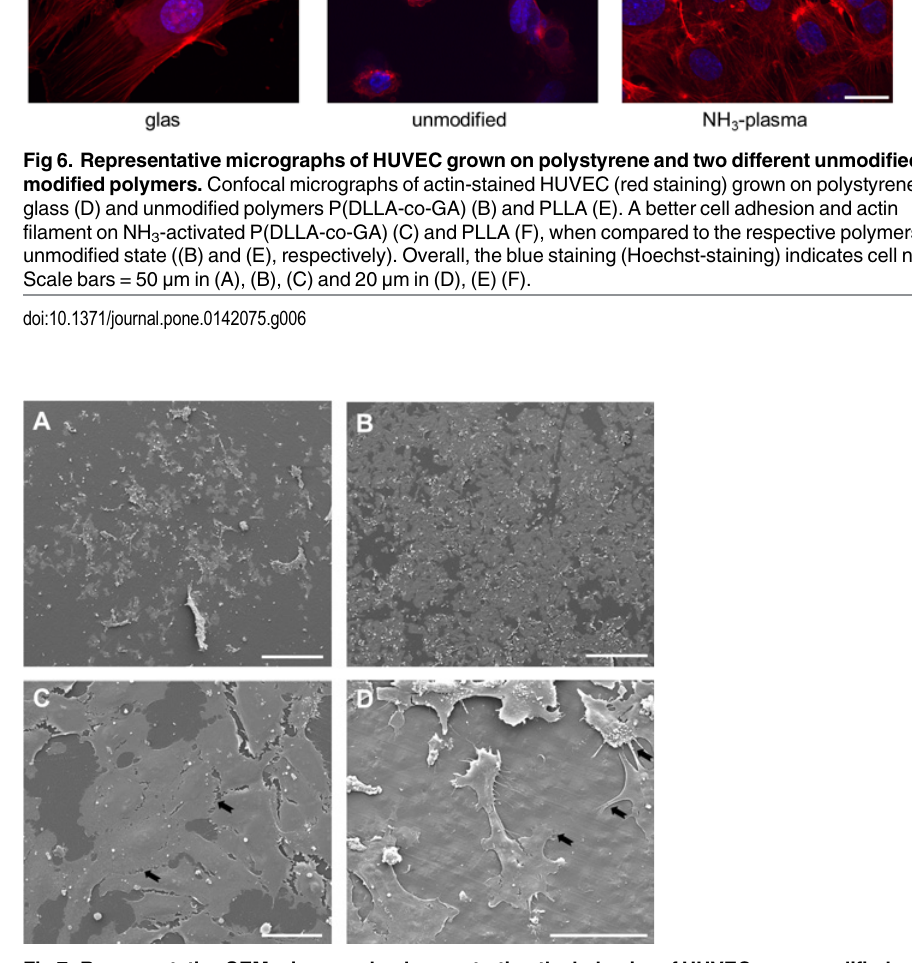
Fig 7. Representative SEM micrographs demonstrating the behavior of HUVEC on unmodified and modified PLLA. SEM micrographs of HUVEC grown on unmodified (A) and NH 3 -modified (B) PLLA. (C) and (D) show details of cell morphology and distribution on NH 3 -modified PLLA at a higher magnification. Black arrows in (C) indicate zipper-like manner cell contacts. In (D) extensions of the plasma membrane are marked with black arrows. Scale bars = 500 μ m in (A) and (B), 50 μ m in (C) and